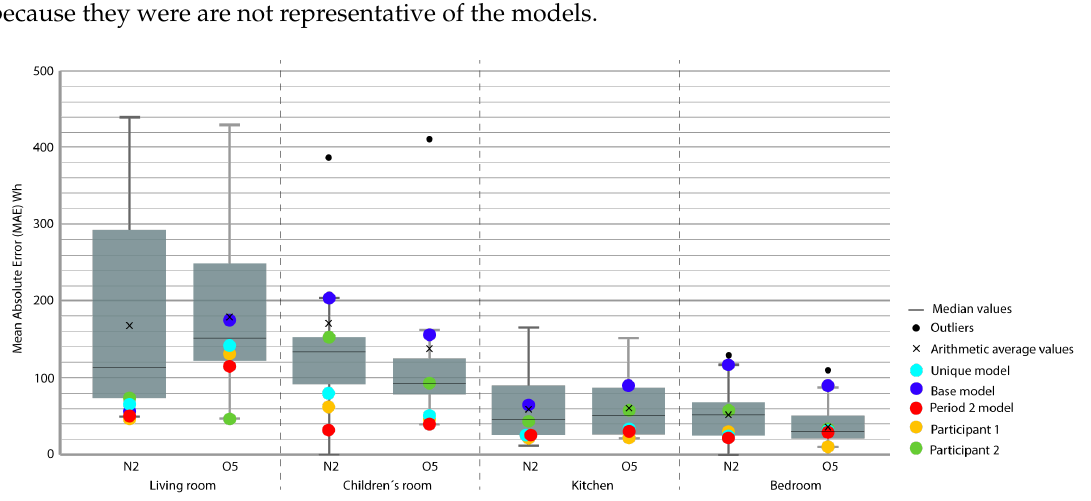
Figure 4. Energy mean absolute error (MAE) for Period 2 (fixed set point at 30 ◦ C).